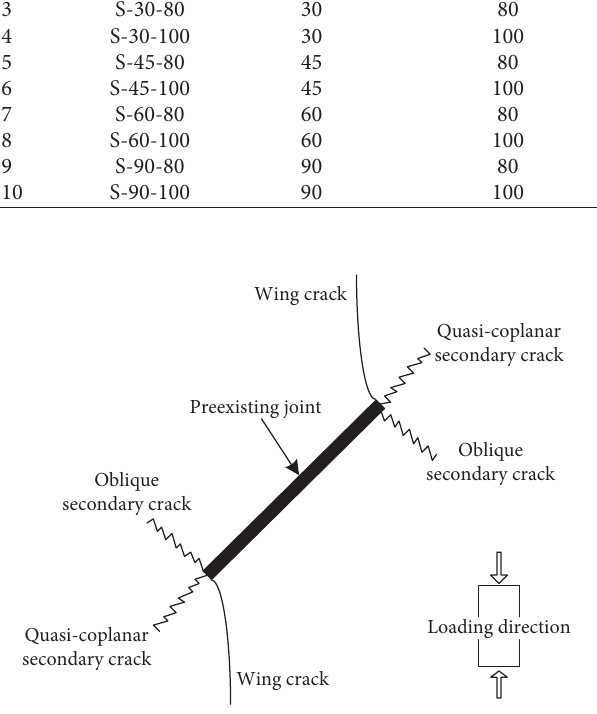
Figure 3: Crack types observed in the preexisting joint specimen under uniaxial loading [38,